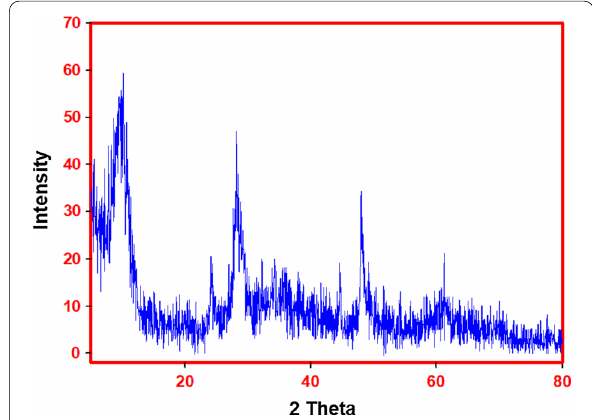
Fig. 1 XRD patterns of sodium titanate nanotubes (TNTs)